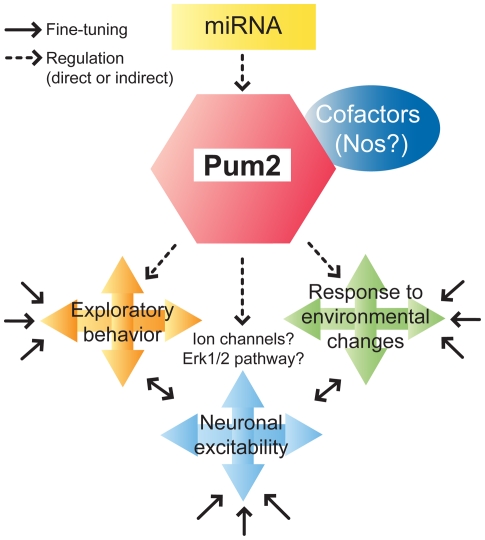
Hypothetical model of Pum2 function in the mouse CNS.
Pum2-mediated fine-tuning of regulatory pathways may affect neuronal excitability and other neural functions. This may be achieved by modifying the expression of ion channels. Pum2 function, in turn, is thought to be fine-tuned by miRNAs [10], [15] and potentially needs co-factors to be effective.